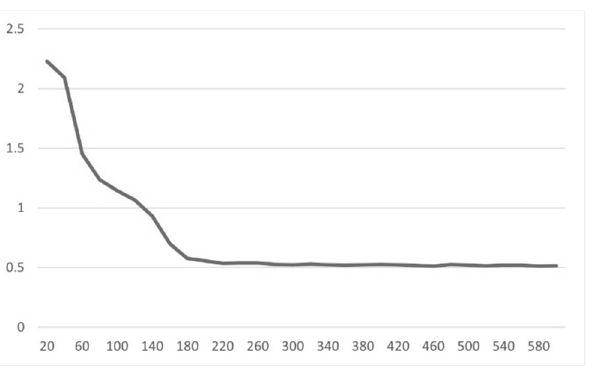
Figure 3. The training curve of the TerraSAR training pass one. The x axis is the iteration with a batch size of 300. The y axis is the average loss of every consecutive 20 iterations with log10 transformation.